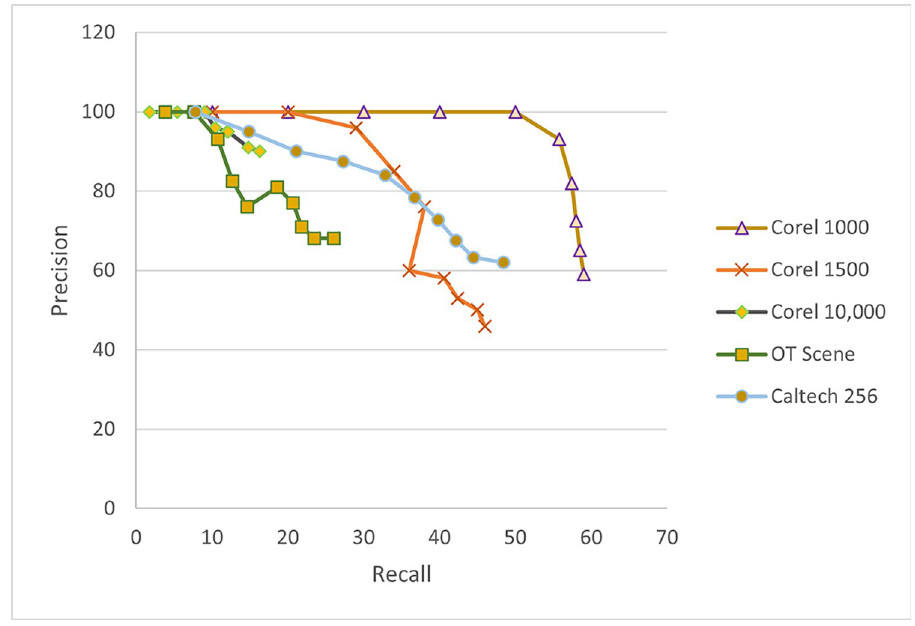
Fig 22. Performance analysis in terms of the precision-recall curve of the proposed method.